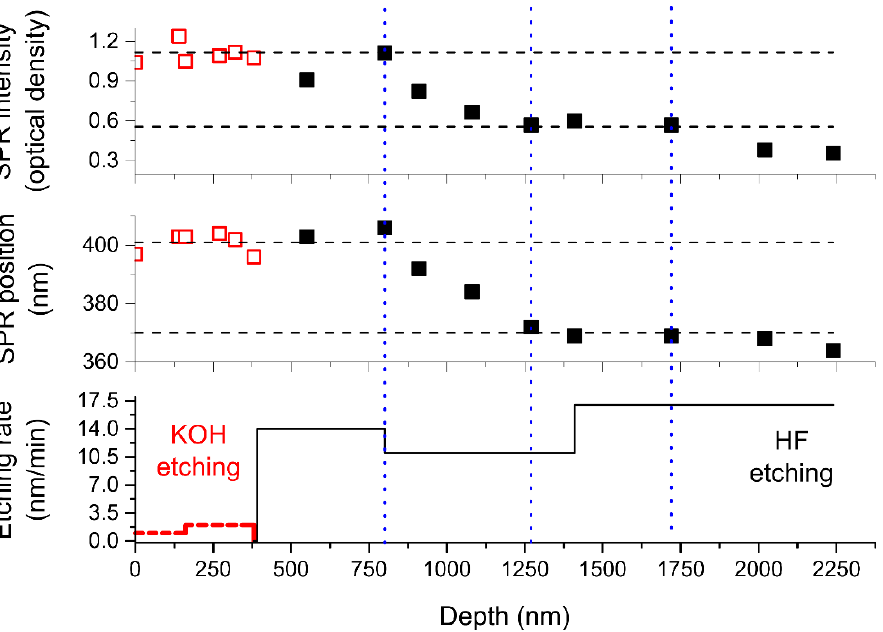
Figure 2. The dependencies of the intensity ( upper ) and spectral position ( middle ) of SPR of silver NPs formed in vacuum-poled glass after the ion-exchange, and etching rate ( lower ) of the glass on distance from the sample surface. Hollow squares/dashed lines correspond to KOH etching, and black squares / solid lines to NH 4 F/HF etching. The etching rate of ~17 nm/min (starts from ~1400 nm) corresponds to the non-poled glass after the